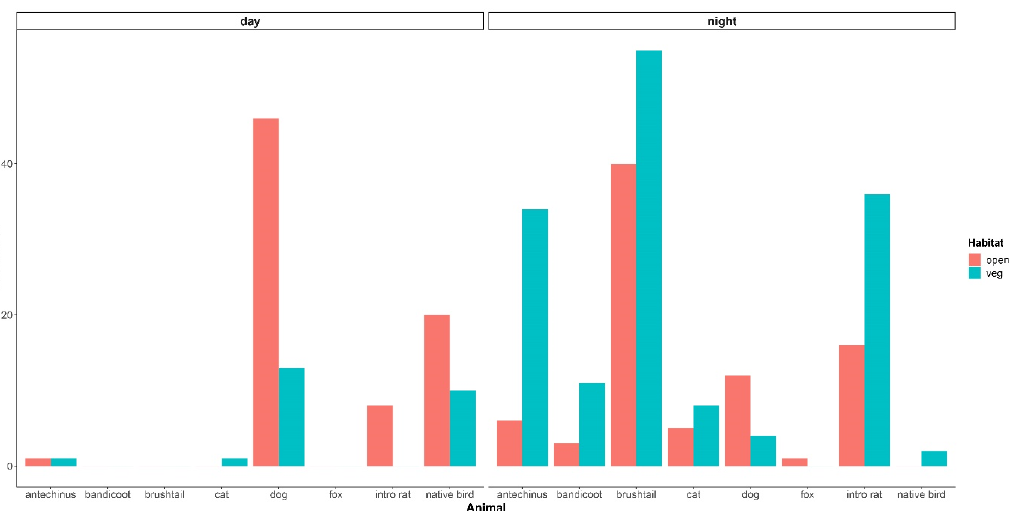
Figure 3. Bar chart of the raw frequency of observations for each animal species/group, in open and more vegetated habitats, divided by day and night. Repeat images of single occurrences per